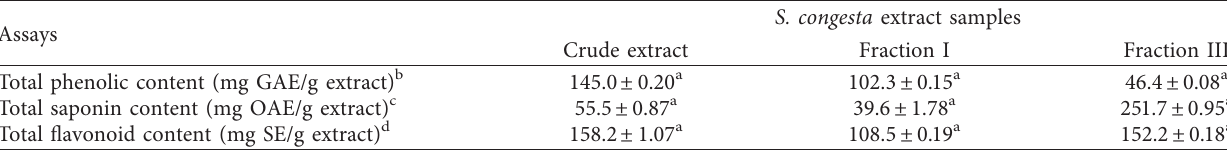
Figure 6: (a) Anti-inflammatory activity of S. congesta crude extract and fractions on COX-2 at a test concentration of 0.1%. Results were expressed as mean ± SD ( n � 6); ∗∗∗∗ p < 0.0001% vs. other CPC fractions; ns vs. fraction I . Statistical analysis was performed by one-way variance analyses (ANOVA) followed by Tukey’s test for post hoc analysis. The relative inhibition of enzymatic COX-2 was calculated with equation (4) between T 2 � 220 seconds and T 1 � 37 seconds. Celecoxib (0.5 µ M) was used as a positive control. (b) Anti-inflammatory activity of S. congesta crude extract and fractions on NF- κ B at a test concentration of 0.1%. Fraction II was further tested at 0.02% due to the results of the cytotoxicity assay. Results were expressed as mean ± SD ( n � 6); ∗∗∗∗ p < 0.0001% vs. control solution (0.1 µ g/mL TNF alpha); ∗ p � 0.0114% vs. control solution (0.1 µ g/mL TNF alpha); ns vs. TNF alpha control solution (0.1 µ g/mL TNF alpha). Statistical analysis was performed by one-way variance analyses (ANOVA) followed by Dunnett’s post hoc analysis (test compound vs. TNF alpha control solution). The inhibition of cellular NF- κ B was calculated with equation (5). Dexamethasone (10 µ M) was used as positive control. Table 3: Quantification of different secondary metabolite